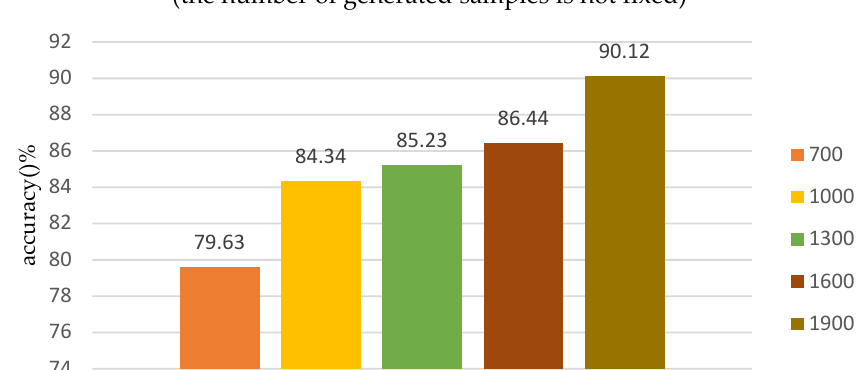
Figure 10. As the number of original real samples used to train unidimensional ACGAN changes, the average accuracy of unidimensional DenseNet changes, and the number of generated samples is the same as the number of original training samples.